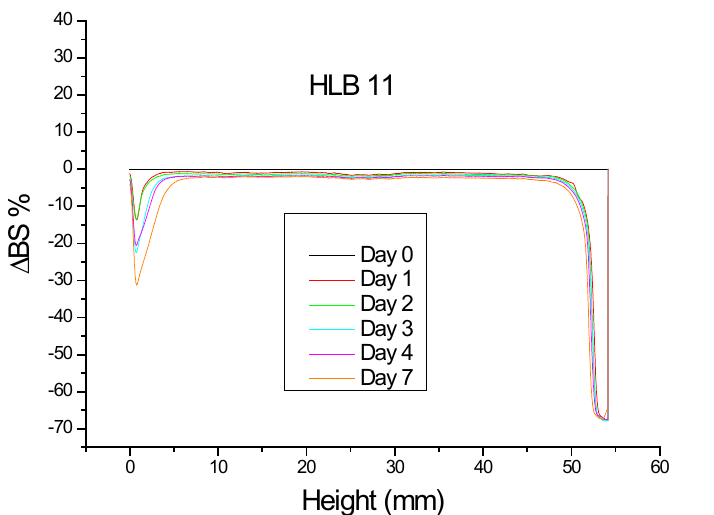
Figure 4. Variation of BS with aging time as a function of height of the measuring cell for the nanoemulsion with an HLB number of 11.